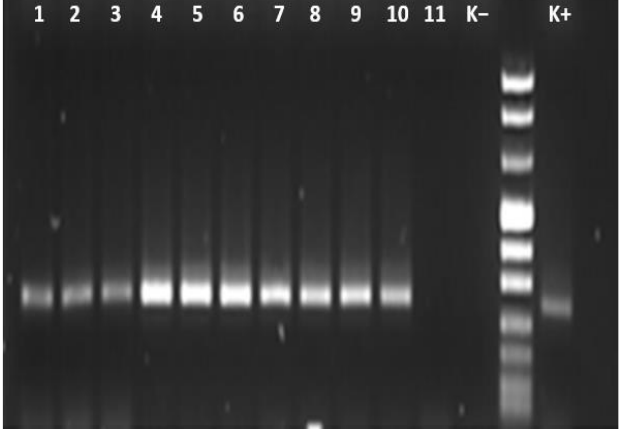
Figure 1. Agarose gel electrophoresis (1.5%) of PCR amplification products of Anaplasma spp. with 16S rRNA primer. Lanes 1 – 11: numbers of the strains; Lane 11: K( − )-negative control; Lane 12: DNA